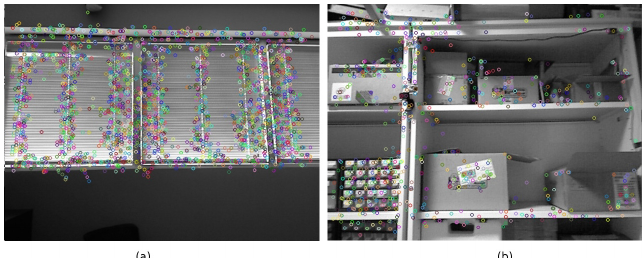
Figure 2. ( a ) A narrow view showing many key points on many close objects. ( b ) Close view but with high scattering of interest points in